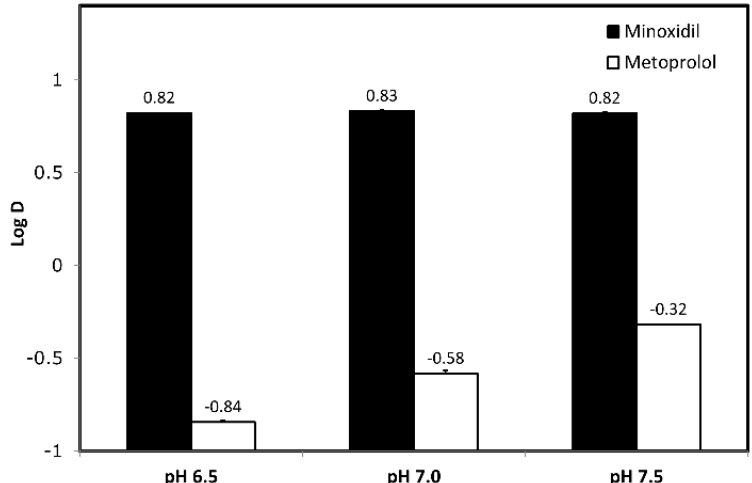
Figure 1. Log D values obtained for minoxidil (vs. metoprolol) at the three pH values 6.5, 7.0 and 7.5. Mean + SD; n = 6.